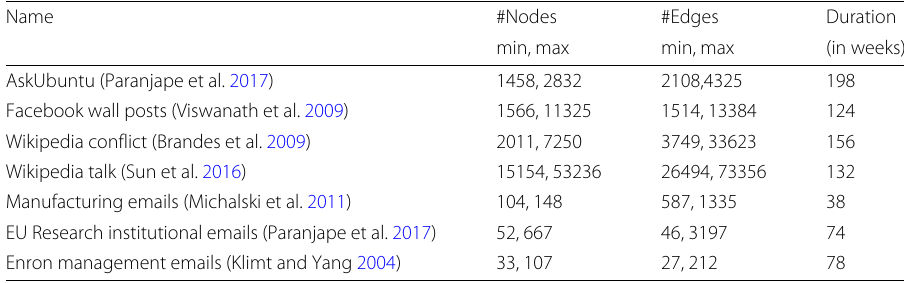
Table 1 Real-World datasets